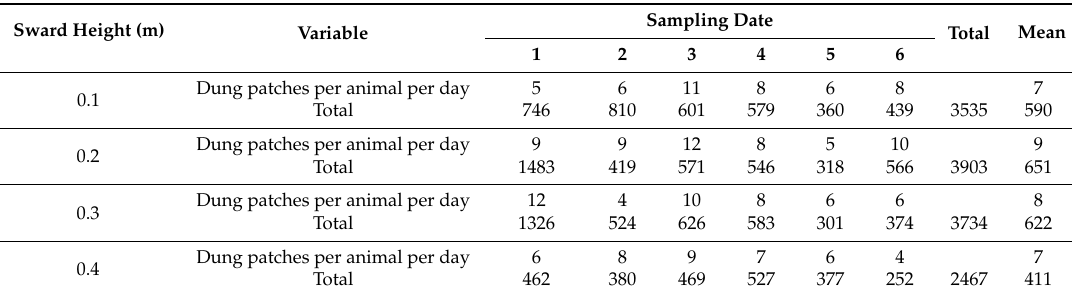
Table 2. Number of dung patches per animal per day at di ff erent grazing intensities (sward